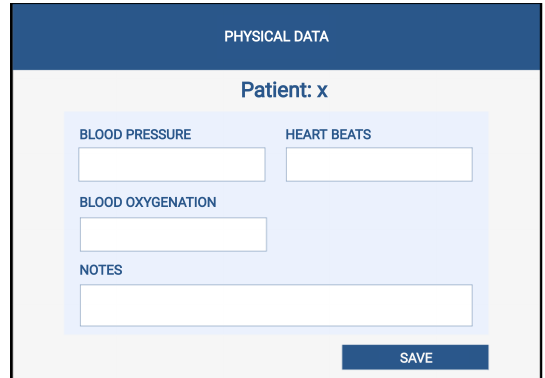
Figure 3. Physical data registration screen. Source: Author (2022).